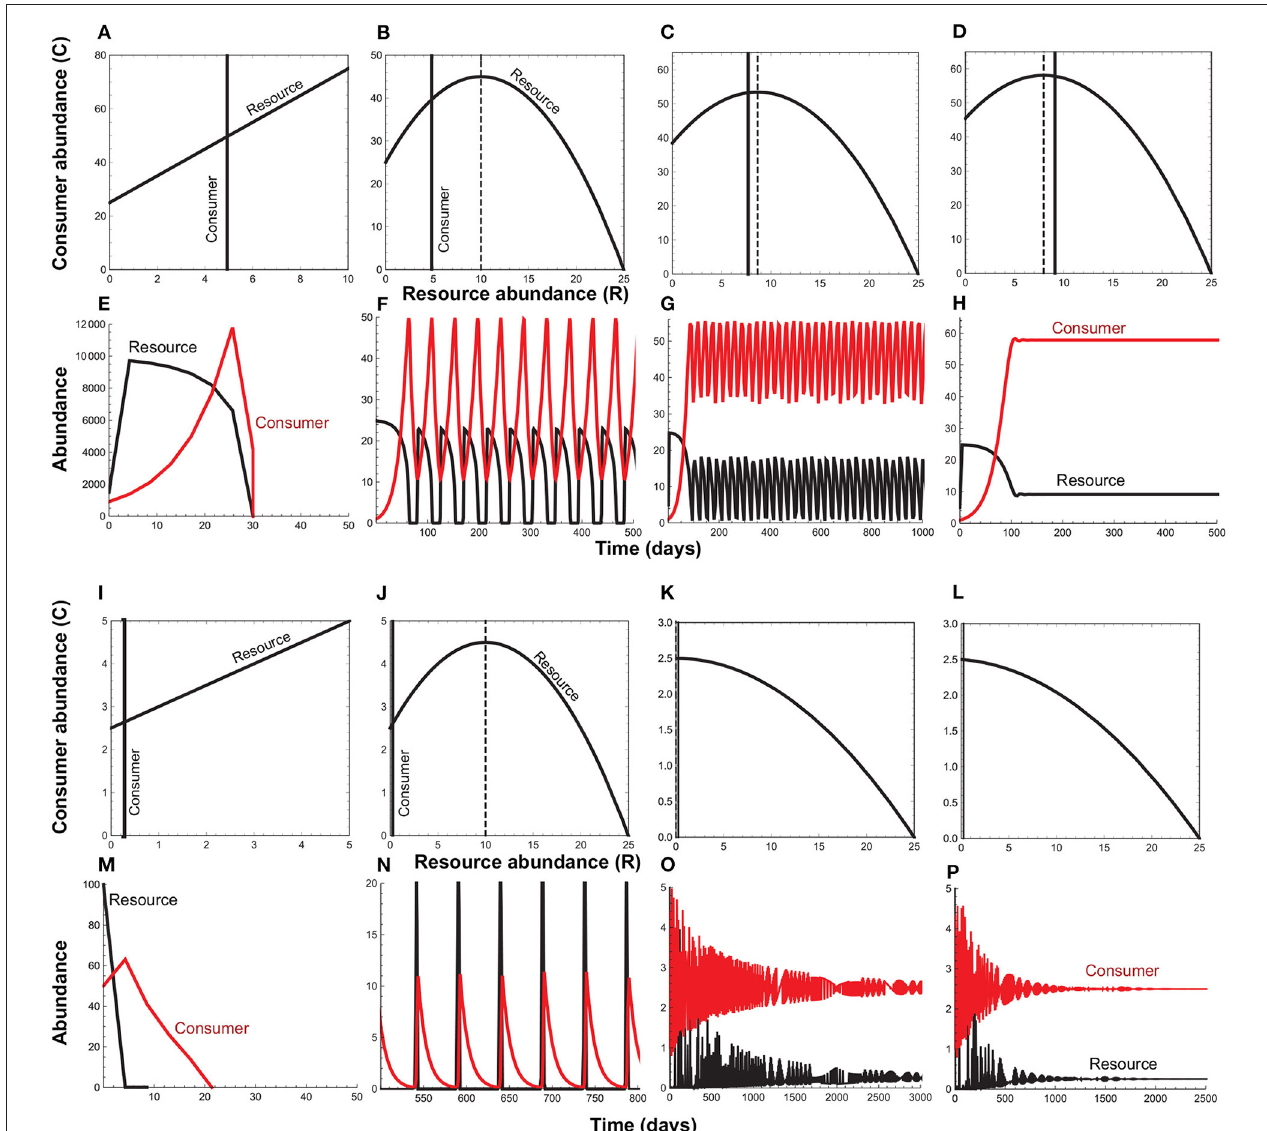
FIGURE 1 | Phase diagrams and time series plots for the consumer-resource model (Equation 1) when the strength of positive feedback ( ah ) changes relative to the r (1 − qR )(1 + ahR ) strength of negative feedback ( q ). In the phase plots, the parabola depicts the resource isocline ( C ), the solid vertical line, the consumer isocline a = d ( R ), and the dashed vertical line, the critical resource density at which the consumer-resource interaction transitions from a stable point equilibrium to limit a ( e − dh ) = ah q cycle oscillations ( R c − 1 2 ah ). (A–H) depict the case (low attack rates and long handling times) that maximizes the resource species’ fitness, with the attack rate = decreasing from left to right while the handling time remains constant. (I–P) depict the case (high attack rates and short handling times) that maximizes the consumer species’ fitness, with the handling time decreasing from left to right while the attack rate remains constant. In both cases, when resource self-limitation is weak to non-existent ( q 0), divergent oscillations lead to the collapse of the consumer-resource interaction (A,E,I,M) . Stronger self-limitation can prevent collapse, but as ≈ long as attack rates remain large and handling times long, oscillations cause resource species’ abundances to fall to levels that predispose them to extinction d (B,F,J,N) . It is only when attack rates and handling times are low enough to cause the equilibrium resource abundance ( R ⋆ ) to approach the critical resource a ( e − dh ) = density ( R c ) that the minimum resource density sufficiently exceeds zero to prevent extinction at low abundances (A,G,K,O) . When attack rates and handling times fall to level that cause R ⋆ to exceed R c , oscillations dampen to a stable point equilibrium (D,H,L,P) . Parameter values are as follows. (A,E) : q 0.0001, a 0.2, h 1.0; = = = (B,F) : q 0.04, a 0.2, h 1.0; (C,G) : q 0.04, a 0.13, h 1.0; (D,H) : q 0.04, a 0.11, h 1.0; (I,M) : q 0.0001, a 2.0, h 0.1; (J,N) : = = = = = = = = = = = = q 0.04, a 2.0, h 0.1; (K,O) : q 0.04, a 2.0, h 0.02; (L,P) : q 0.04, a 2.0, h 0.018. Common parameters are: r 5.0, d 0.1, e 0.2. = = = = = = = = = = = = 2011) or (ii) phenotype matching, i.e., the consumer